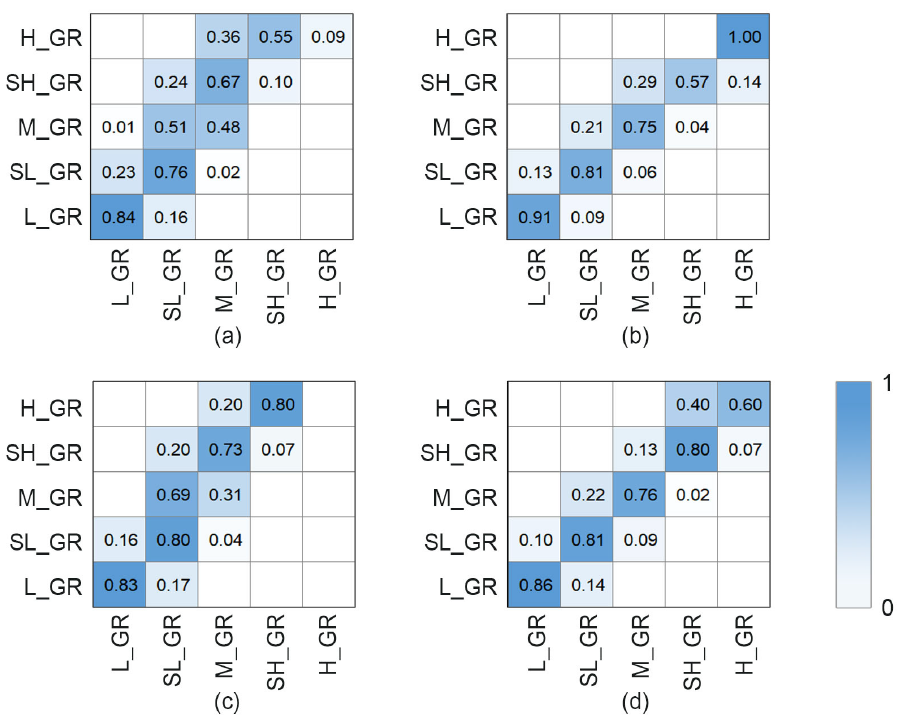
Figure 3. The DD between different resolutions of data in fishnet with various sizes.